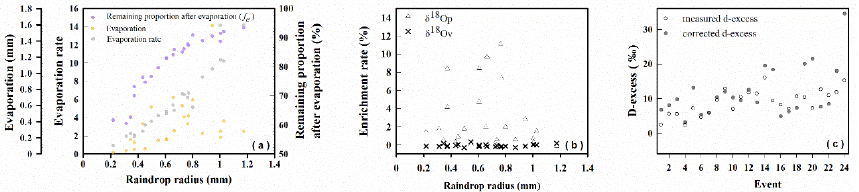
Figure 3. ( a ) Evaporation rate, evaporation and remaining proportion after evaporation varying with raindrop radius. ( b ) Distribution of evaporation enrichment rate of heavy isotopes (E p ) and the size of raindrops. ( c ) The d-excess of measured and after correction in precipitation.